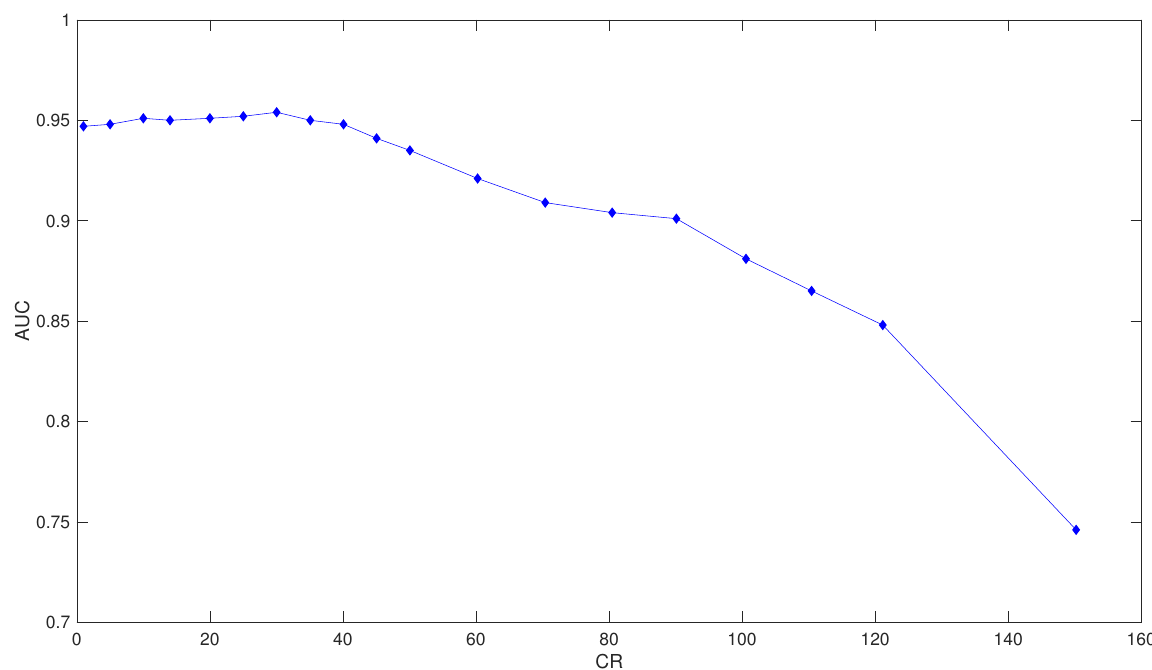
Figure 4. ROC curves from non compressed signal (blue), CR = 90.112 compressed signals (red) and CR = 120.19 (yellow).